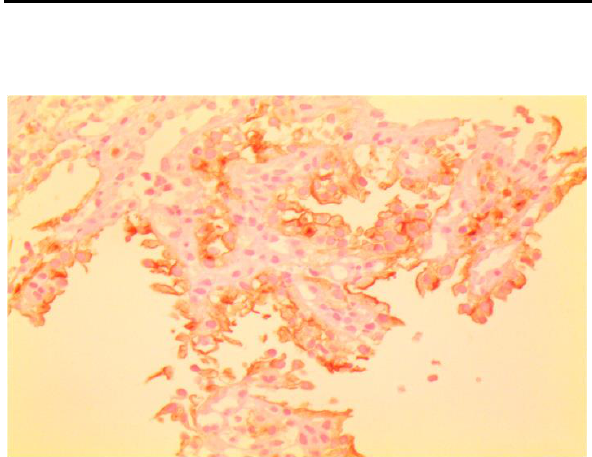
Fig 1. Aggregation of Large Cells With Abundant Cytoplasm